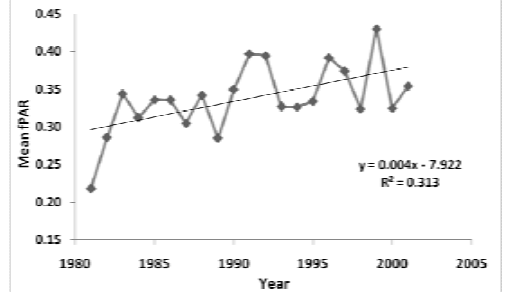
Figure 3. Mean fAPAR in the past decades (1981 to 2001) in Gangotri region.